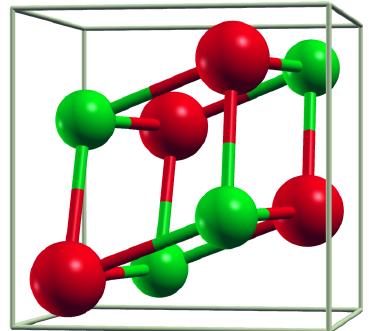
Figure 1. Unit cell of B20 (FeSi-type) crystal structure. Red and green balls are metal and Si atoms,